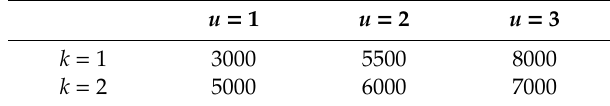
Table 8. The capacity of each vehicle type and